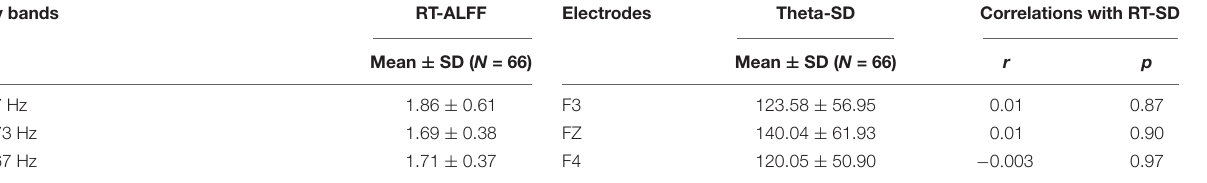
Frontiers in Psychology |